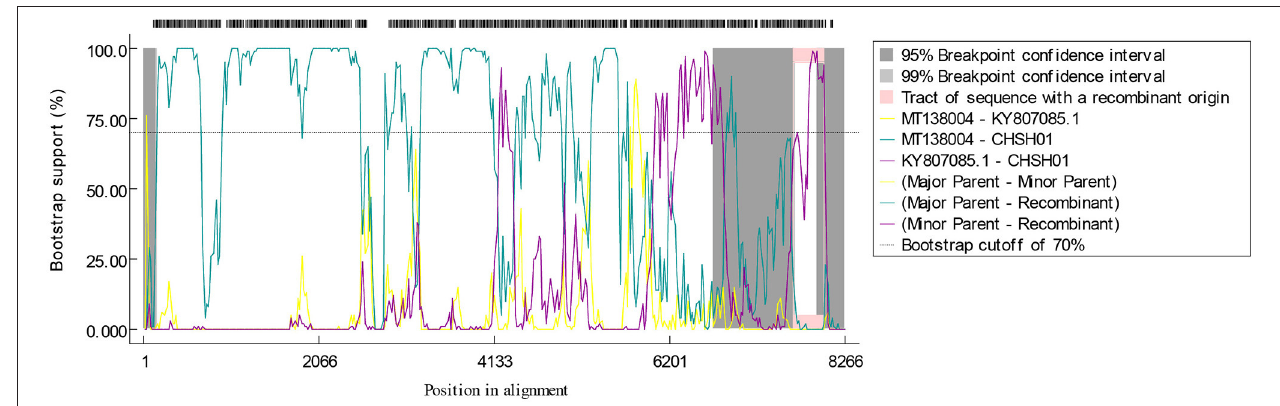
FIGURE 4 | Recombinant identification of CHSH01 strain. BOOTSCAN evidence for the recombination origin on the basis of pairwise distance, modeled with a window size 200, step size 20, and 1,000 Bootstrap replicates. The green, purple, and yellow shadow boxes showed the parental